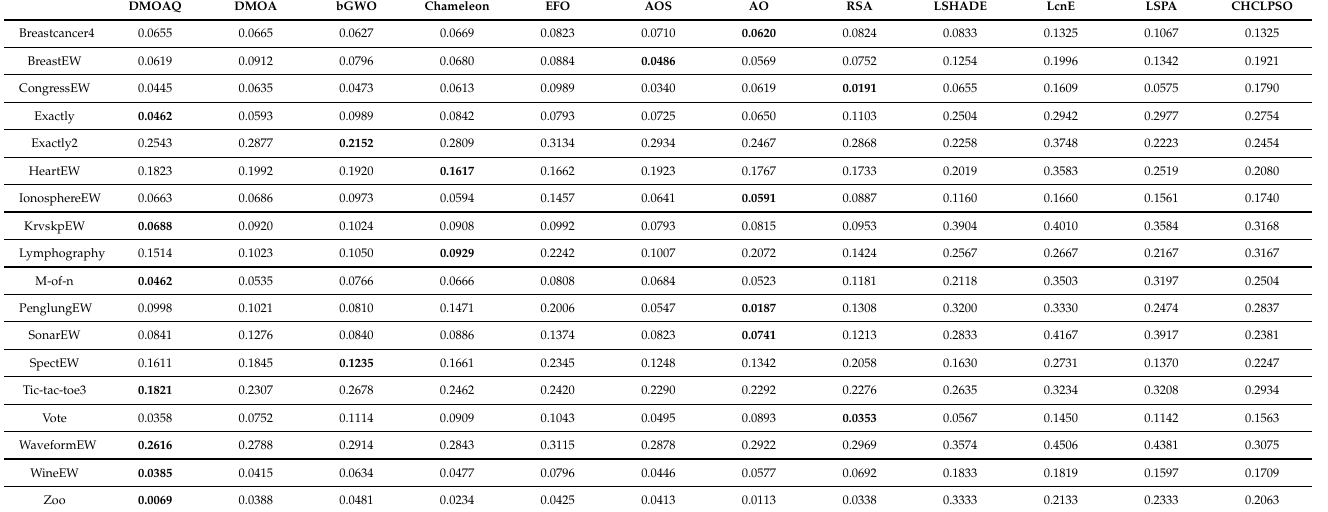
Table 3. Average of the fitness function values.